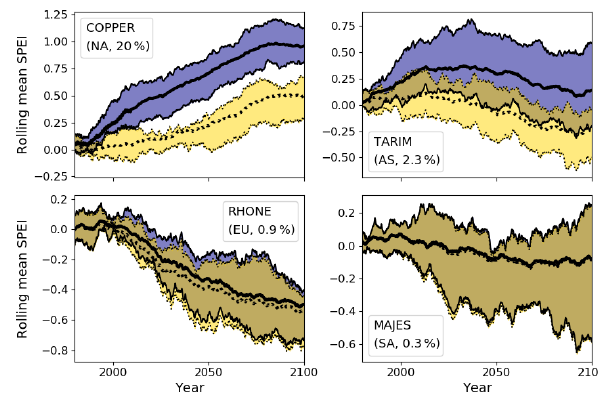
Figure 1. 30-year running ensemble mean and interquartile range of SPEI 3mo with glacial runoff (blue shading) and without (yellow shading) for the RCP 4.5 scenario in four example basins (name, region, and percent glacier coverage by area in the corner of each figure panel). ‘NA’ indicates North America, ‘AS’ Asia, ‘EU’ Eu- rope, and ‘SA’ South America.